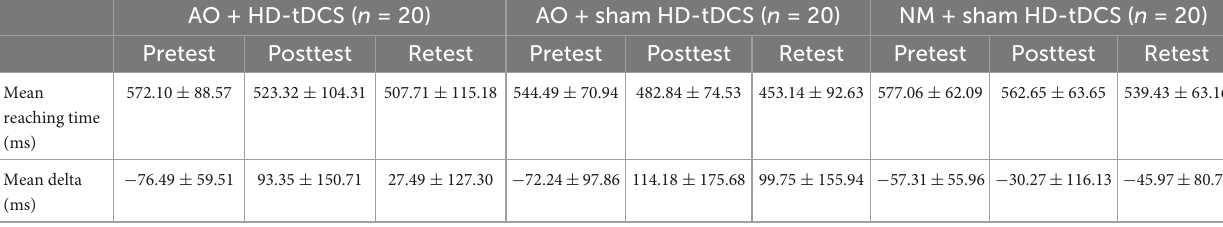
TABLE 1 Mean values and standard deviations of measures reaching time and